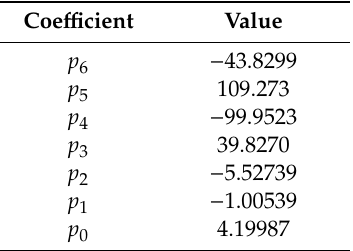
Table 1. Coe ffi cients of the polynomial open circuit voltage (OCV) function [11].